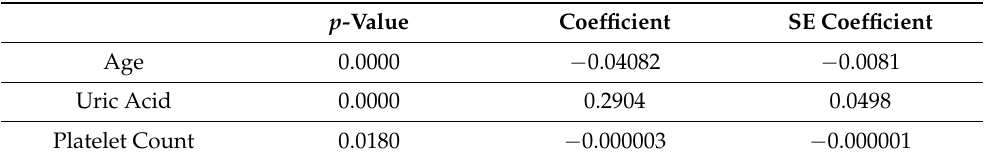
Table 9. Significance of creatinine prediction from uric acid and platelet count according to age based on multiple linear regression. p- Value Coefficient SE Coefficient Age 0.0000 Uric Acid 0.0000 Platelet Count 0.0180 − 0.000001